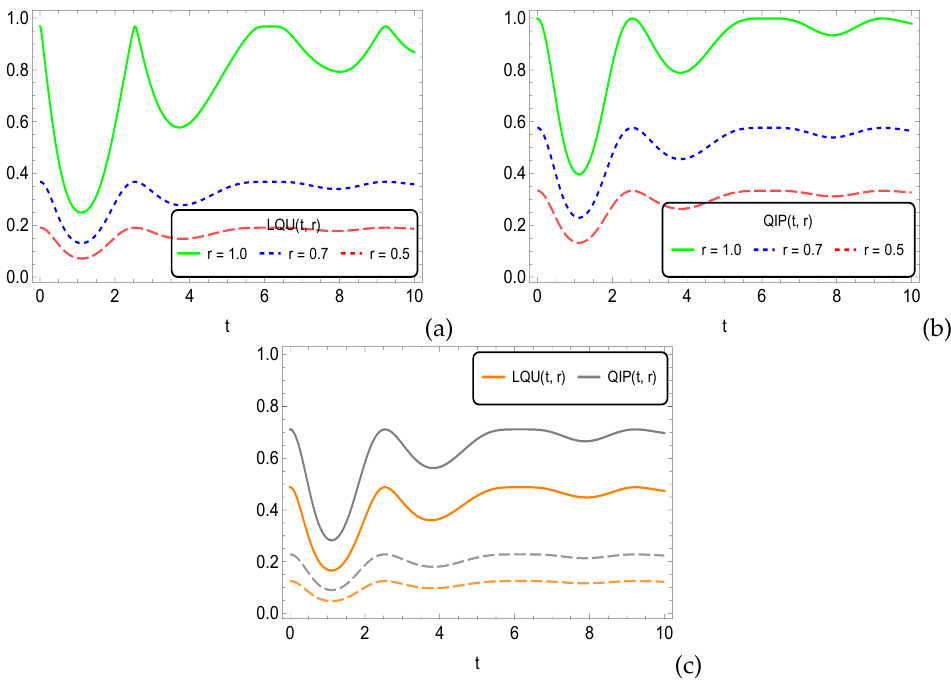
Figure 4. LQU and QIP as a function of time versus different values of r . LQU ( a ) and QIP ( b ). Graph ( c ): r = 0.8 (solid lines) and r = 0.4 (dashed lines). For all plots ∆ = 0.5, ω = π /6, and b =